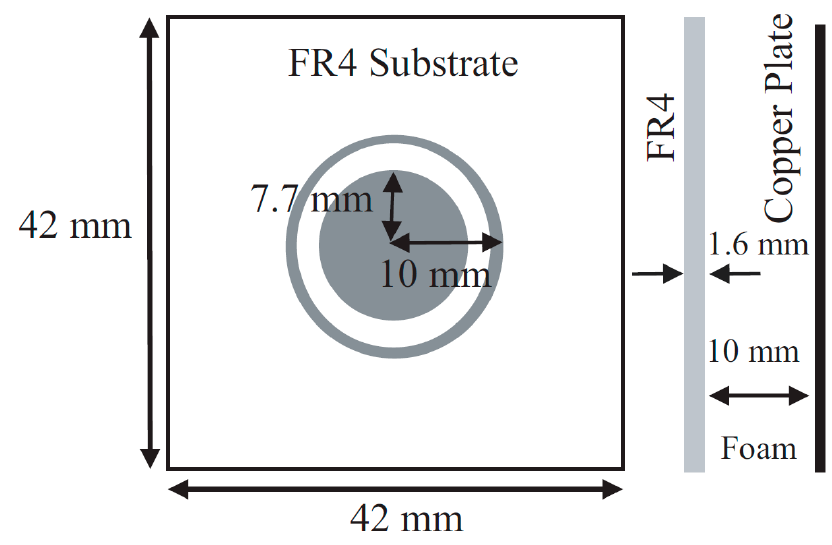
Figure 1. Top view and side view of the circular patch-type unit cell.